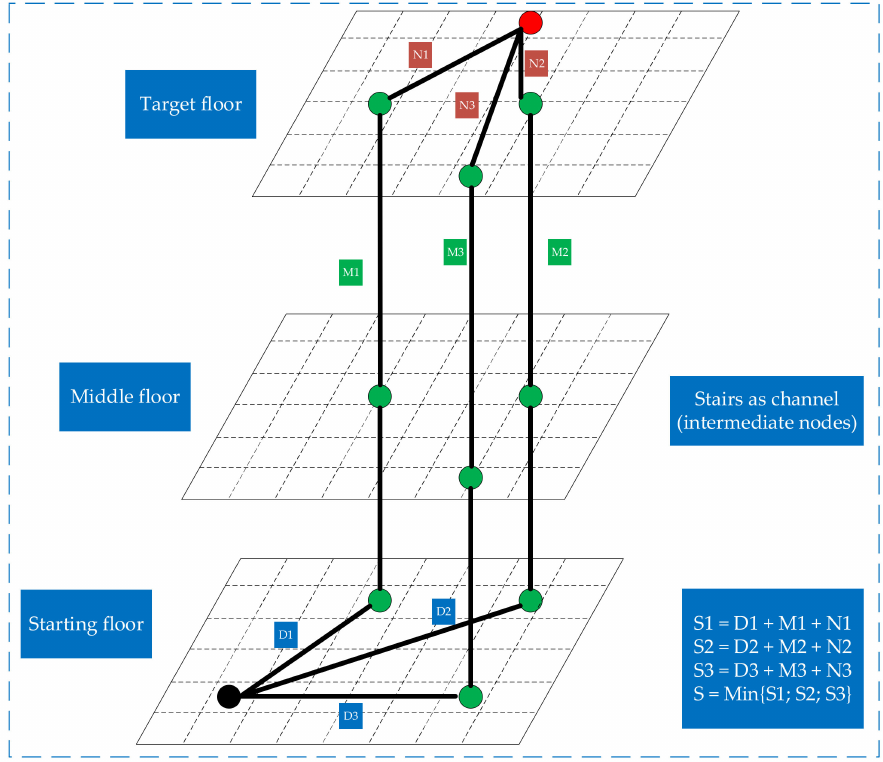
Figure 10. GeoSOT-A* Algorithm Path Planning Display.